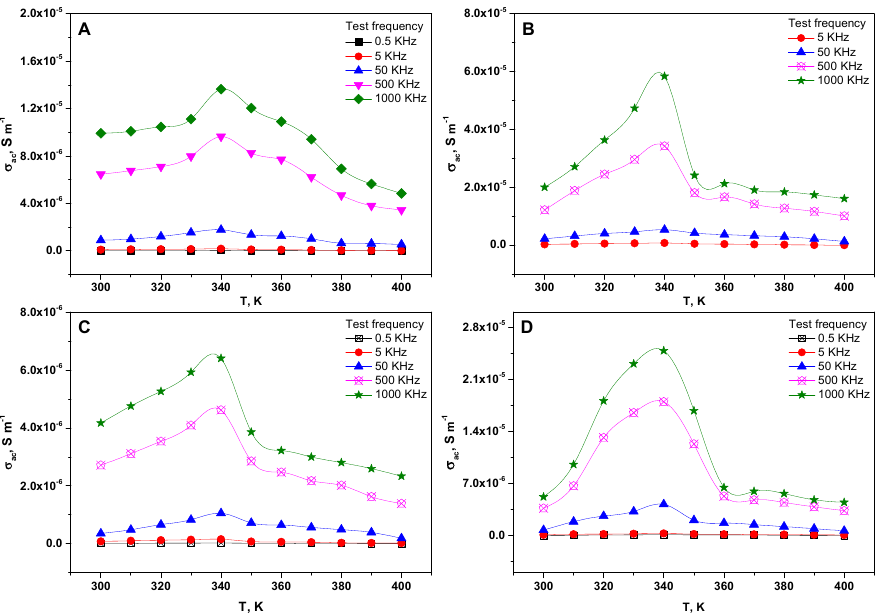
Figure 4 . Temperature and frequency dependence on the AC conductivity for ( A ) poly(EDMA), ( B ) Pd(OAc) 2 /poly(EDMA)-5.1%, ( C ) poly(EDMA-co-MMA), and ( D ) Pd(OAc) 2 /poly(EDMA-co- MMA)-1.6%.